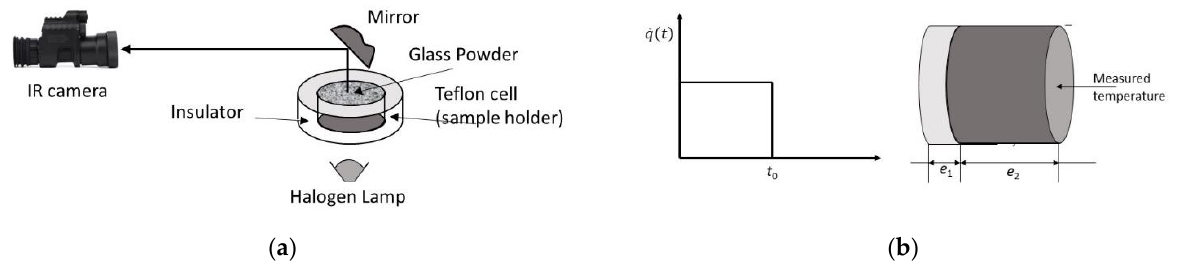
Figure 9. Photothermal method using a finite heating duration: ( a ) schematic of the experimental device and ( b ) schematic of the used sample.